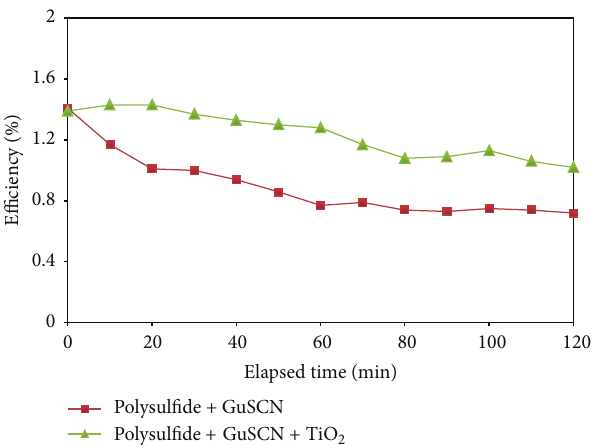
Figure 6: Efficiency variation of CdSe QDSSCs with time under two-hour light soaking. The polysulfide electrolytes used in the cells were with and without added TiO 2 nanoparticles.